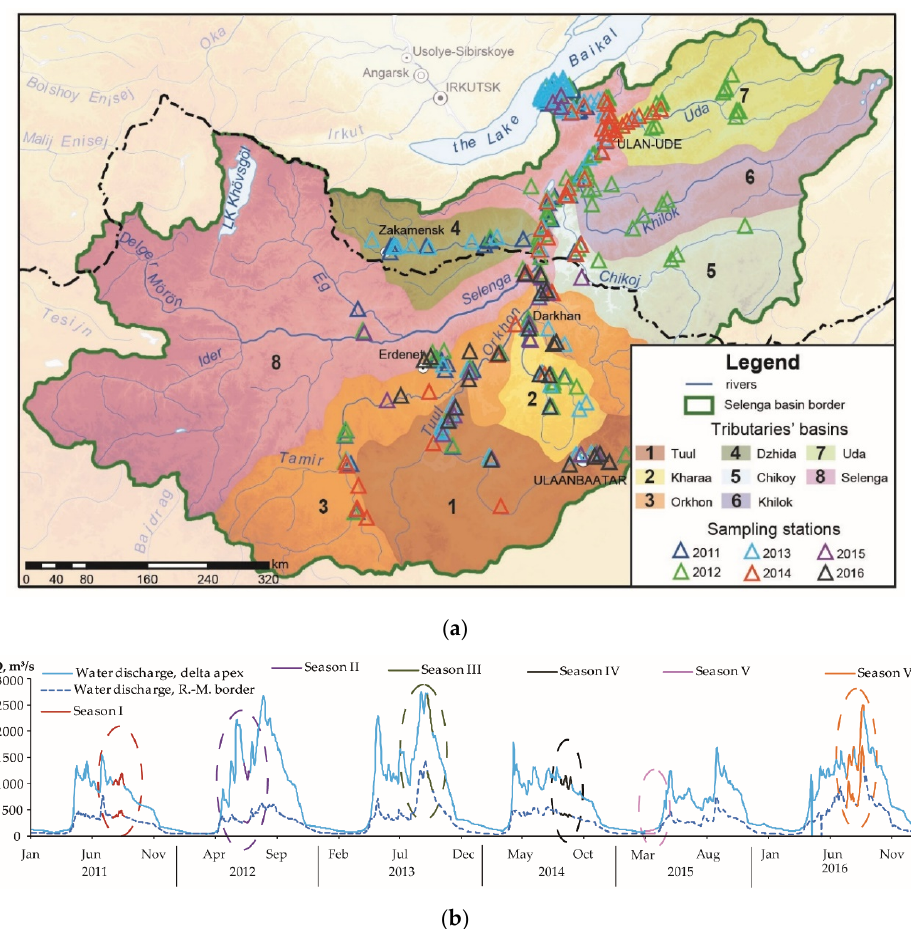
Figure 1. Field data acquisition: ( a ) sampling points, ( b ) water discharges of Selenga River delta apex and near Russian–Mongolian border.